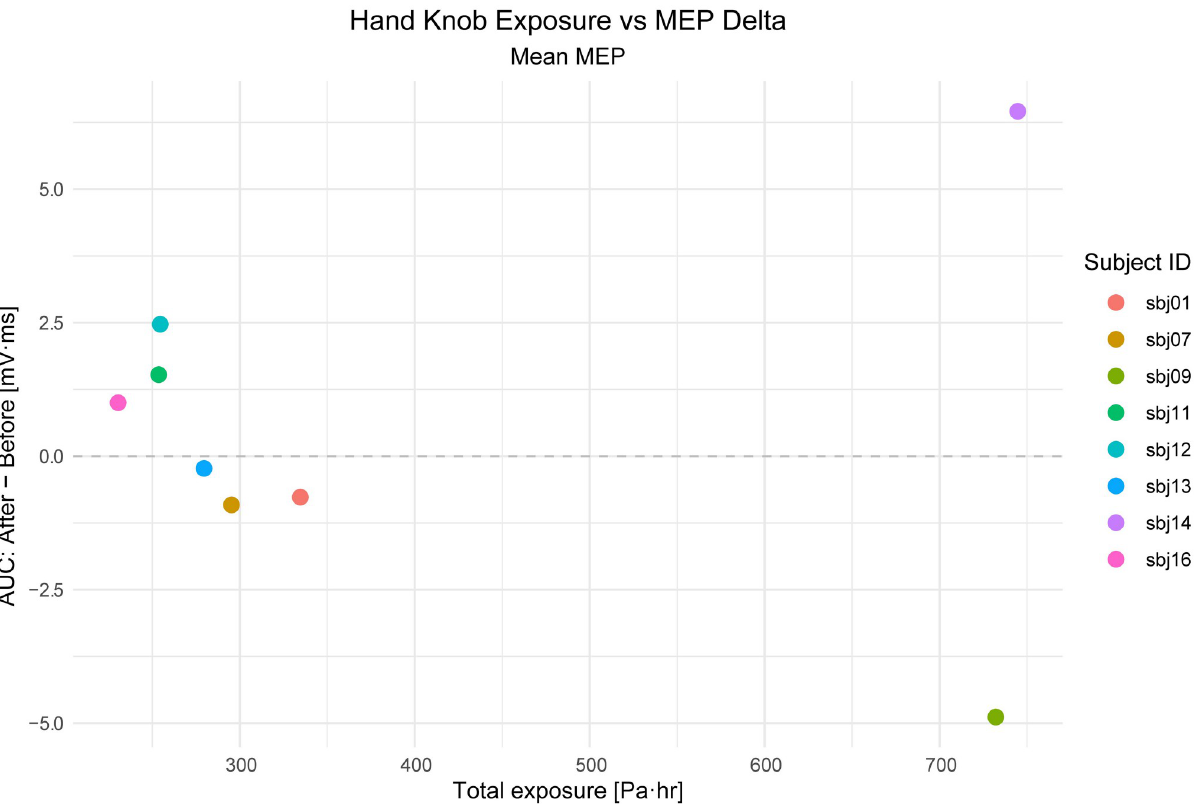
Fig 6. M1 hand exposure vs. cortical excitability. Estimate of total exposure of M1 hand to tUS cumulatively during the session (horizontal axis) compared to the change in cortical excitability, as measured by TMS-evoked MEP (vertical axis). R s = -0.21.